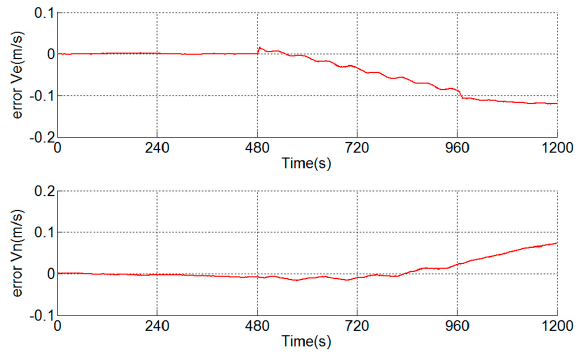
Figure 11. Velocity errors.